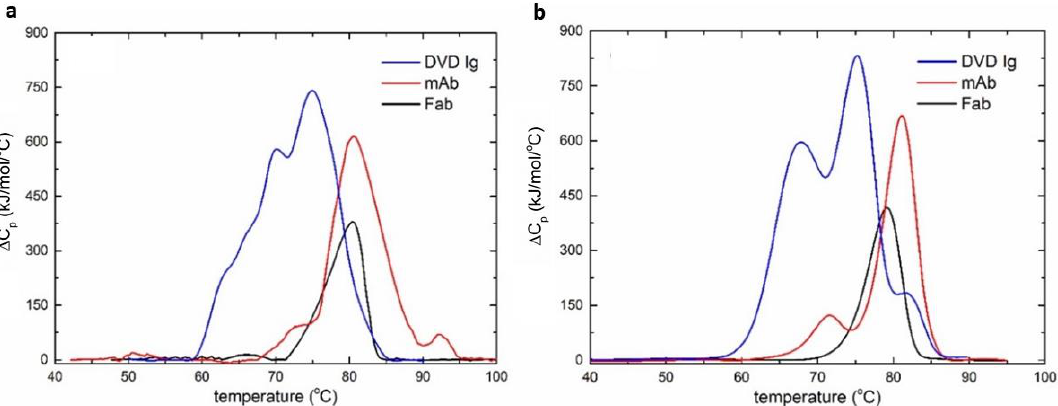
Figure 5. The DSC curves of the three proteins. ( a ) The DSC curves of the three proteins obtained by the MEMS-based DSC. ( b ) The DSC curves of the three proteins obtained by the MicroCal VP- Capillary DSC.